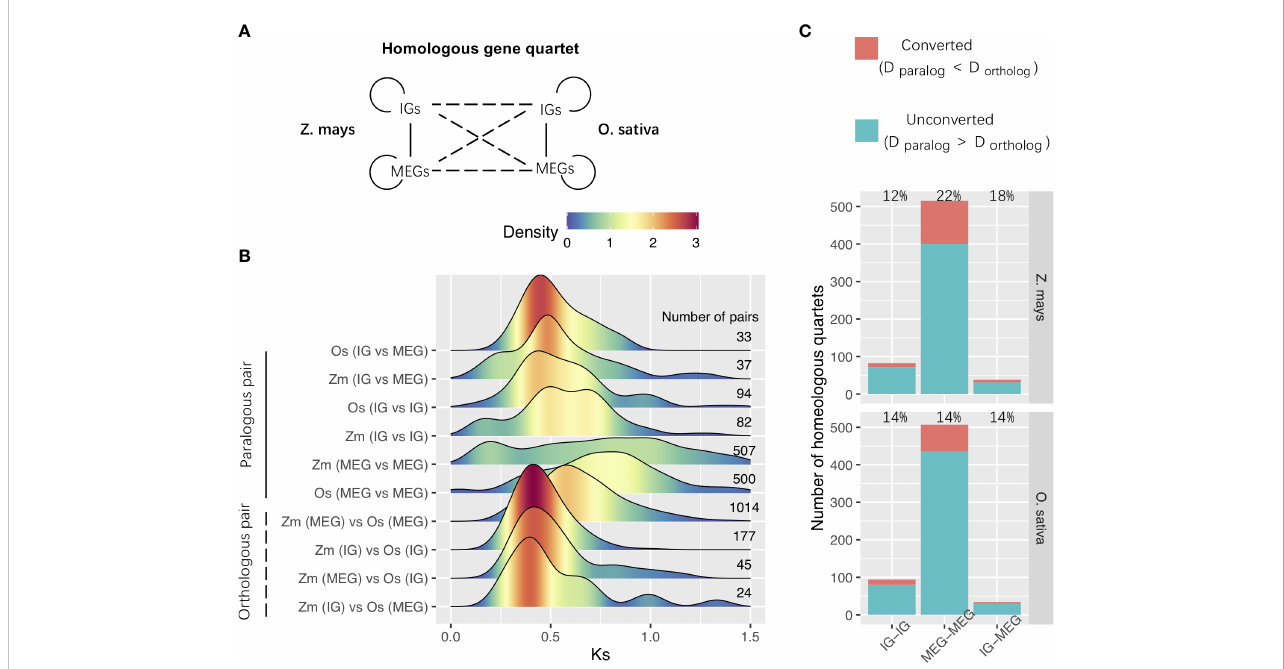
FIGURE 5 WGD-derived homologous gene quartets. (A) Relationships among the homologous gene quartets for Zea mays and O. sativa . Solid and dashed lines represent the paralogous and orthologous relationships between the WGD-derived genes, respectively. (B) Ks distributions for the WGD-derived gene pairs among homologous gene quartets. The number of pairs is shown to the right of the distribution panel. (C) Gene conversion. Conversion rates are provided in the panel. Zm, Z. mays ; Os, O. sativa ; IG, Intronless gene; MEG, multiexon gene; D,